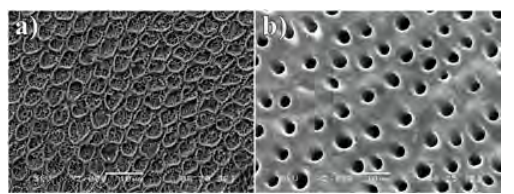
Figure 1. a) Prismatic structure of enamel after phosphoric acid etching (cross-section); b) The sur- face of dentin with dentinal tubules after phosphoric acid etching (cross-section). (SEM, JSM5500-LV, Jeol, Tokyo, Japan).